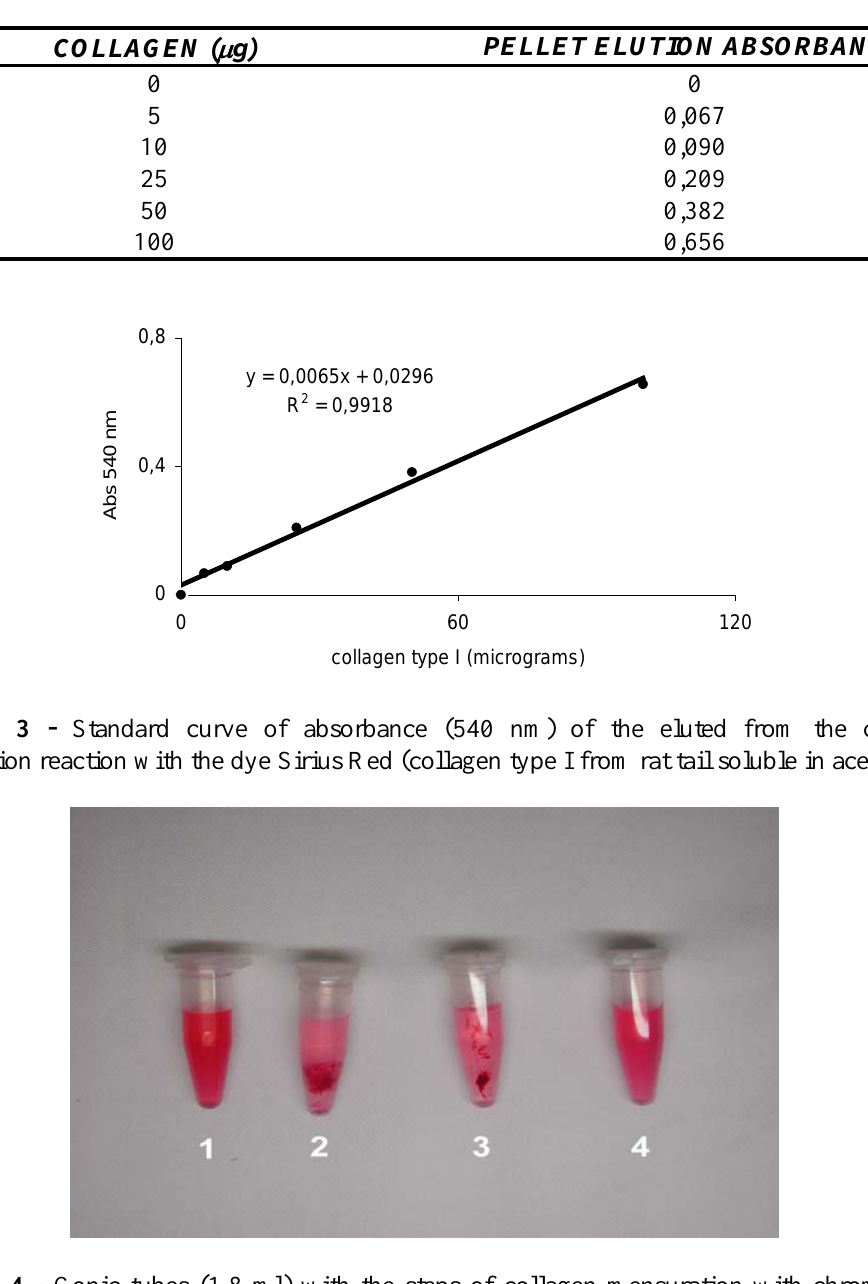
TABLE 1 - Absorbance (540 nm) of the eluted from the collagen precipitation reaction with the dye Sirius Red (collagen type I from rat tail soluble in acetic acid - standard curve).